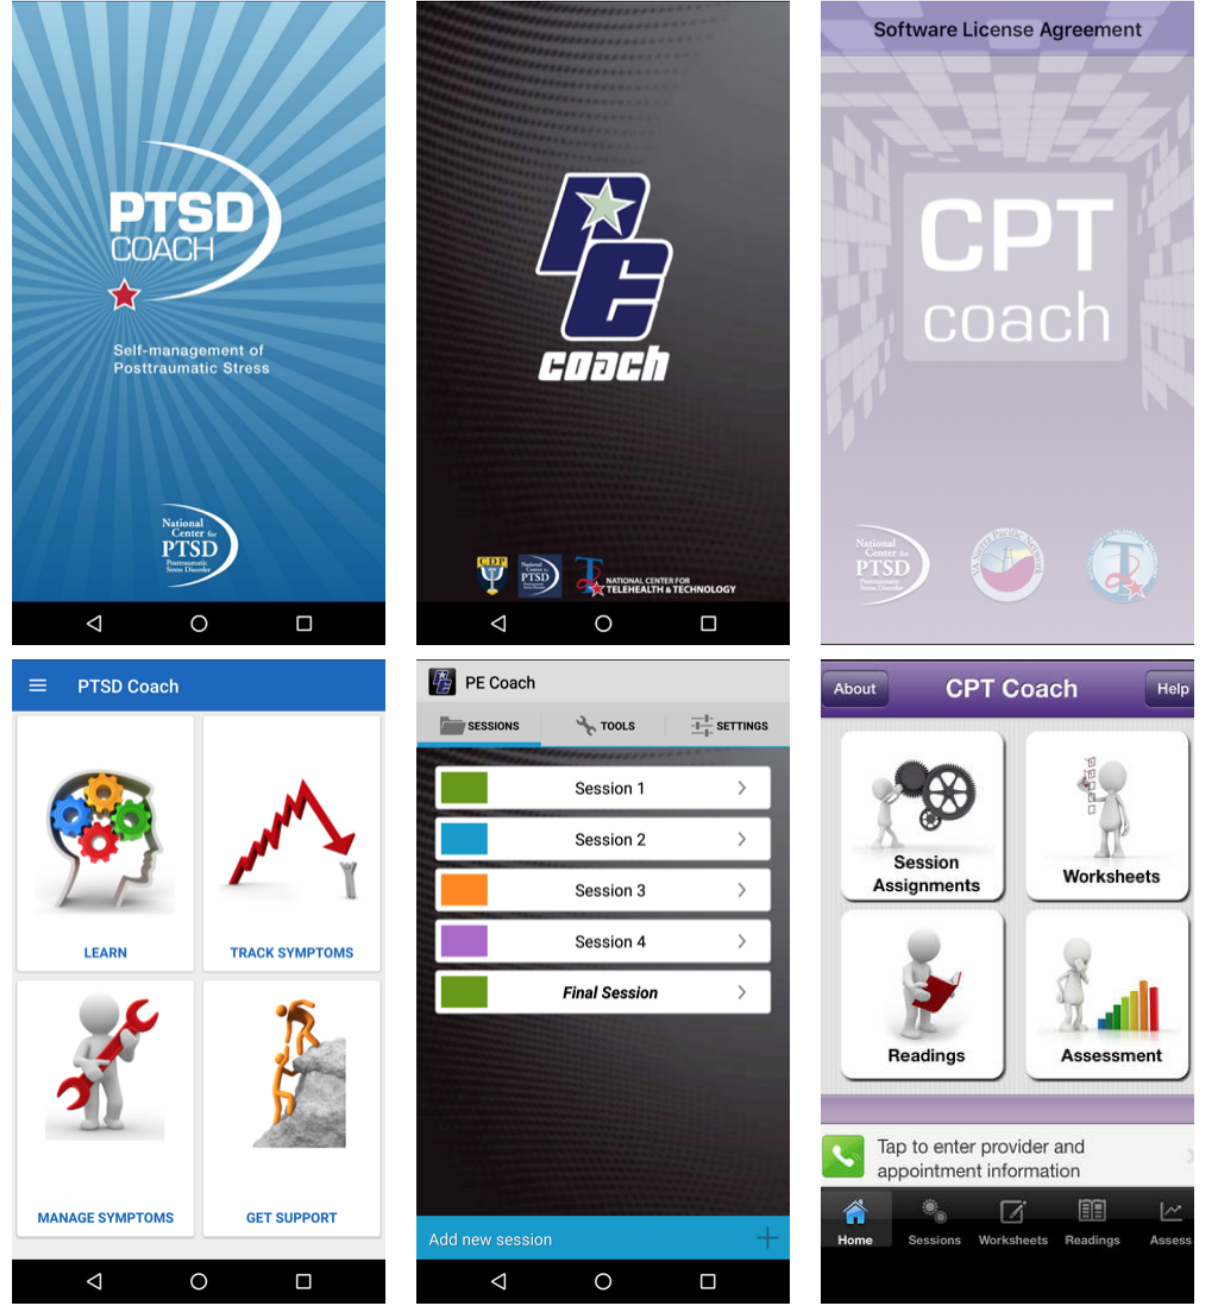
Figure 1. PTSD Coach (left), PE Coach (middle), CPT Coach